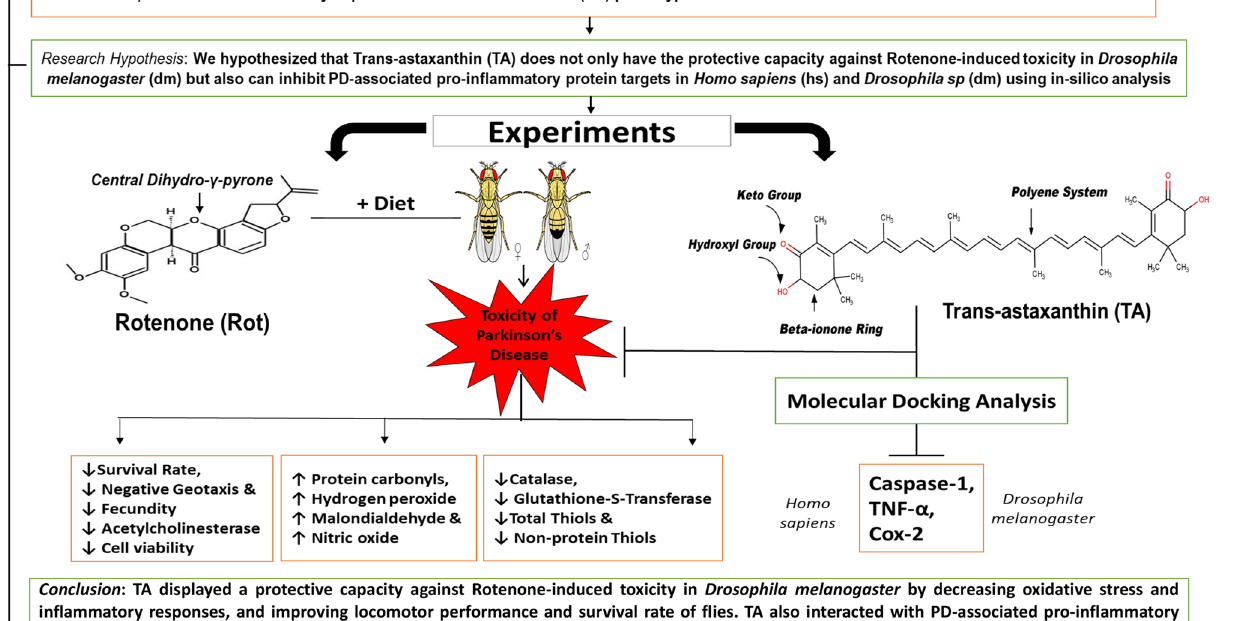
Figure 9. A flowchart showing an overview of experimental steps and